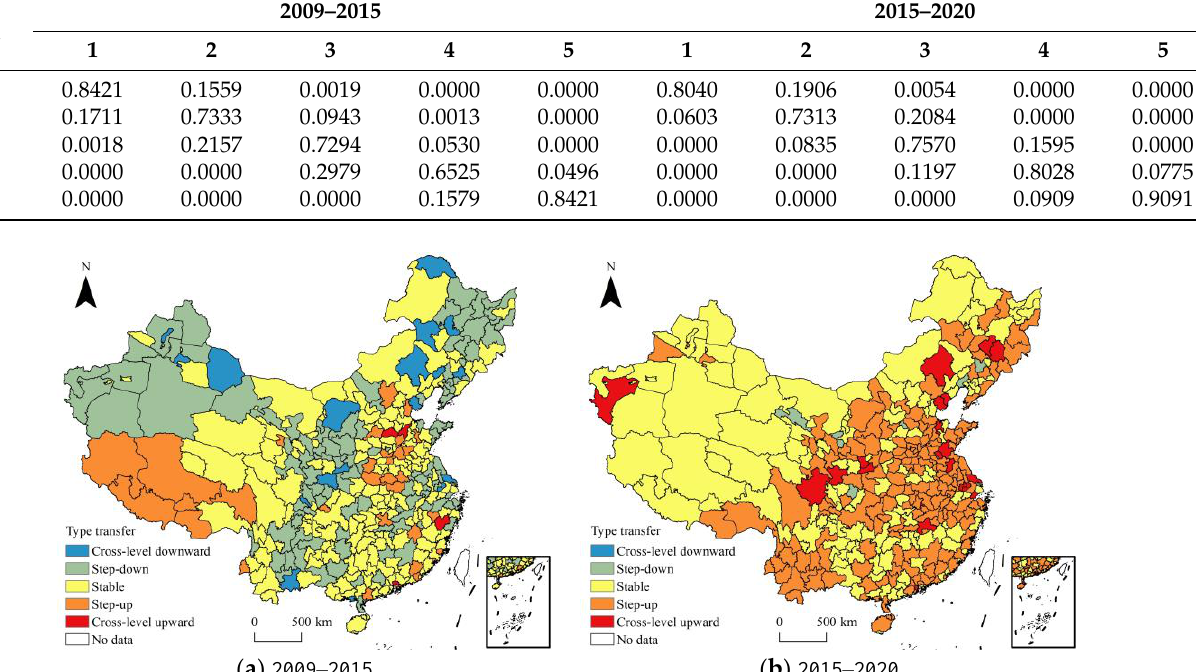
Table 4. Influencing factors of spatial differentiation of PIR in China.